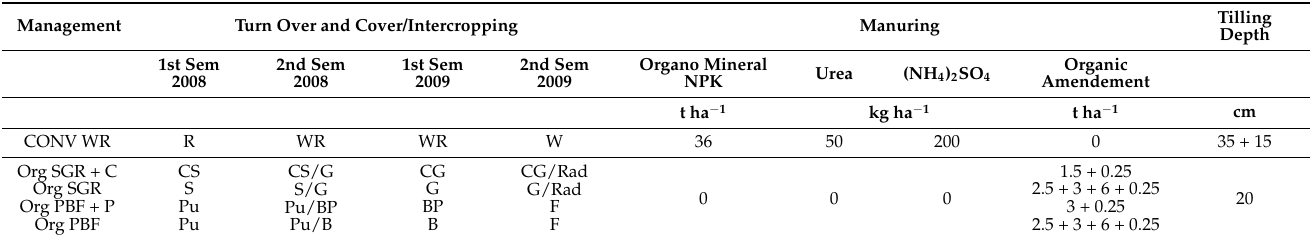
Table 2. Experimental setup.